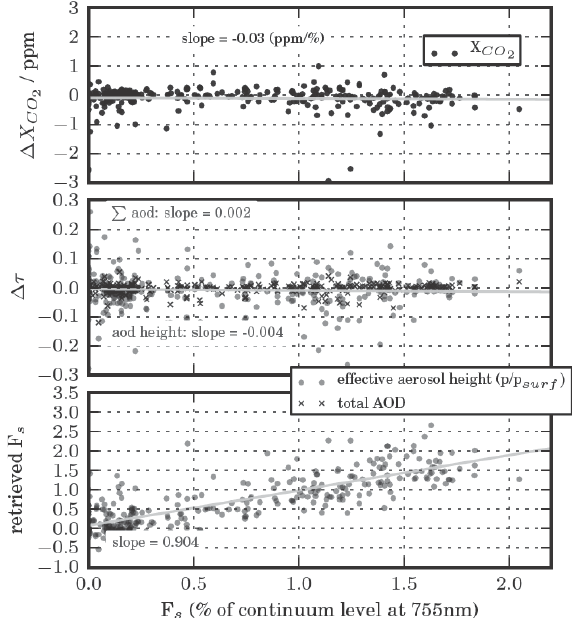
Fig. 8. Case #3b: Changes in retrieved X CO induced by chlorophyll fluorescence if fluorescence is fitted. Apart from the fluorescence fit, identical to case #3a, Fig.